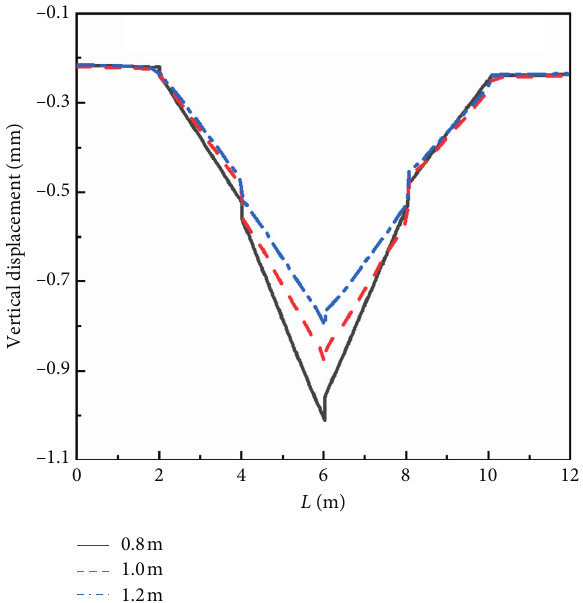
Figure 24: Longitudinal vertical displacement of the crown.